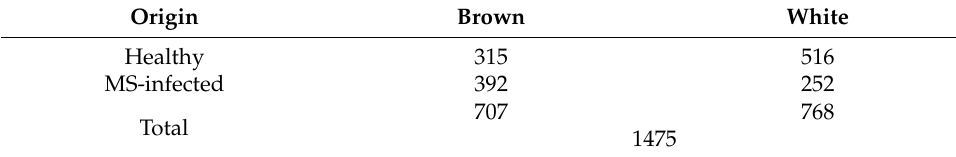
Table 1. Samples: quantity of each egg